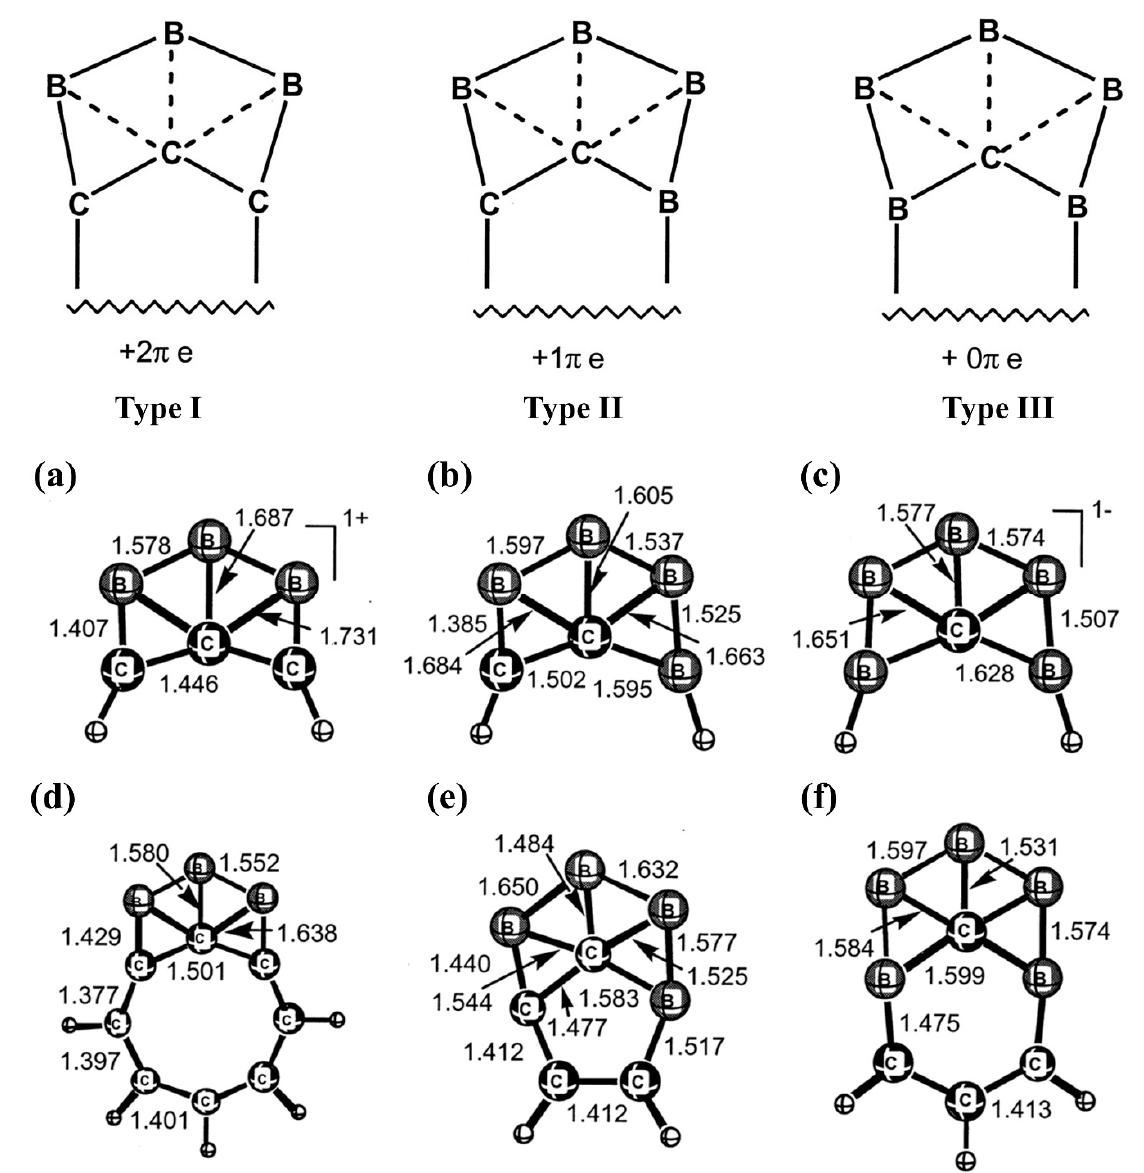
Figure 19. Conceptual relation of the building unit types ( I , II , III ) to stable isoelectronic 4π species with planar pentacoordinate carbons ( a – c ) and the hyparenes ( d – f ). Adapted from ref. [102] with permission from the American Association for the Advancement of Science. Copyright © 2022, The American Association for the Advancement of Science.